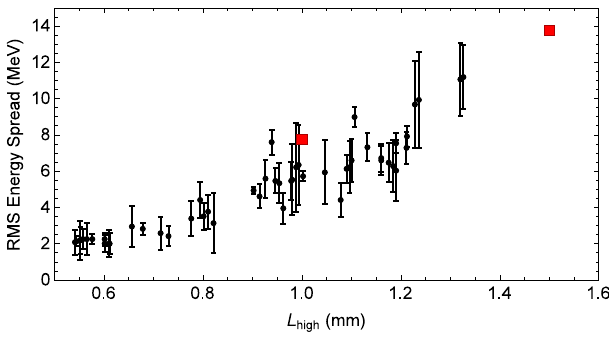
FIG. 5. Energy spread of electron beams against the width of the high density region. Black circles represent experimental data, and red squares represent simulation